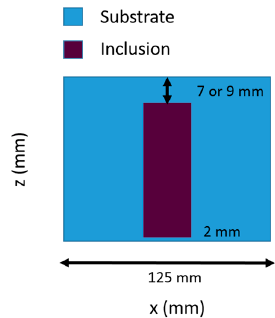
Figure 4. Heterogeneous phantom geometry in x–z plane.